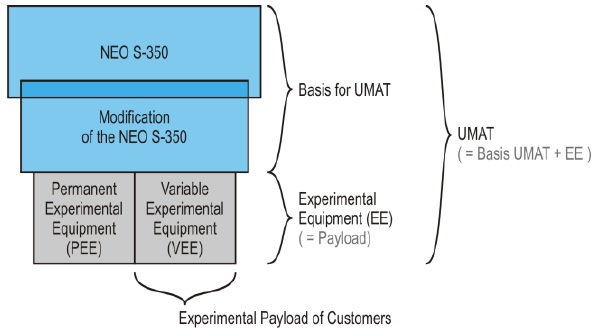
Fig. 3 Unmanned Mission Avionics Test Helicopter based on Swiss UAV NEO S-350